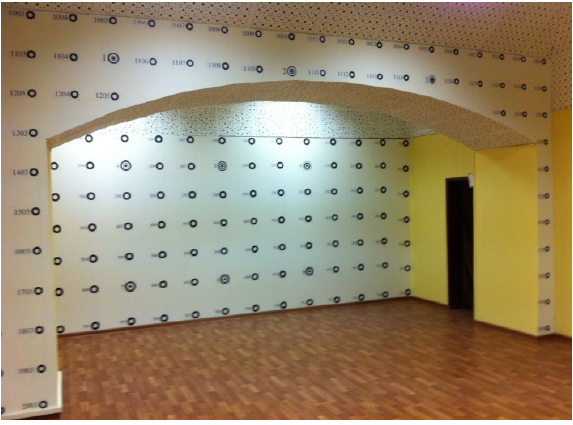
Figure 1. Test-object of (MIIGAiK) for camera calibration.